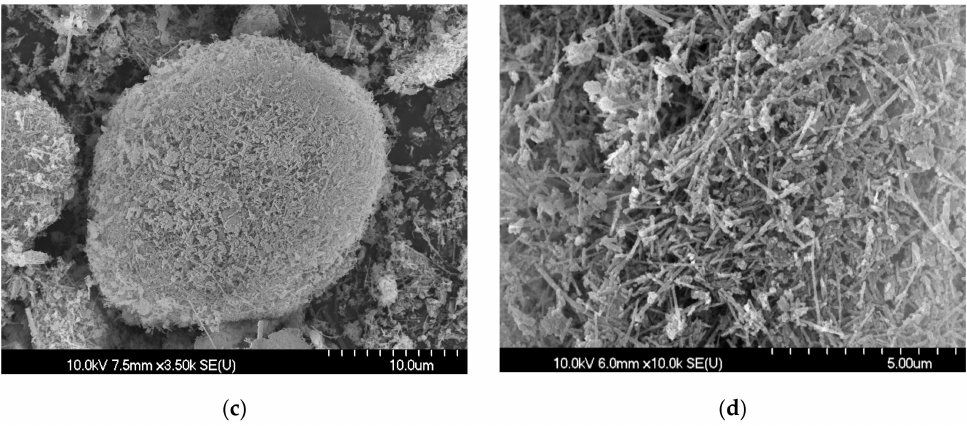
Figure 7. SEM images of waste roofing slate raw material ( a ) and solid samples obtained from cement hydrates removal test using HCl to solid ratio 0.456 g/g ( b – d ).